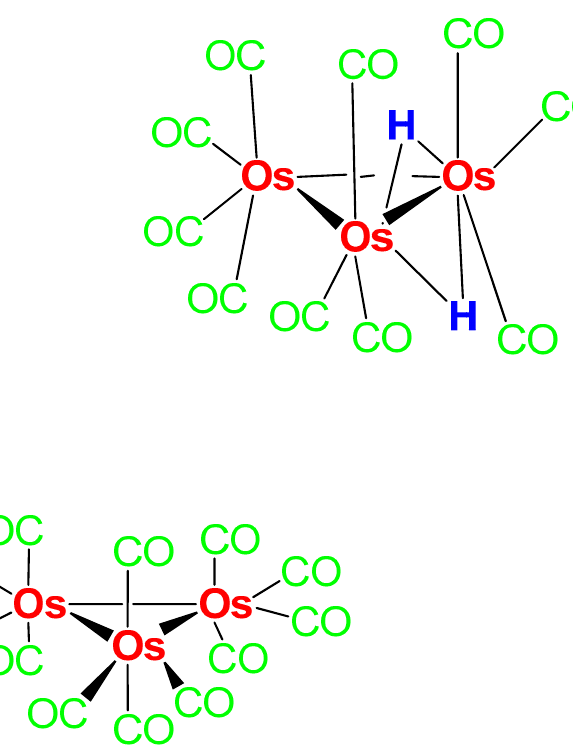
Figure 33. Osmium carbonyls derivatives which extremely efficiently catalyzed the oxidation of alkanes and alcohols with peroxides.